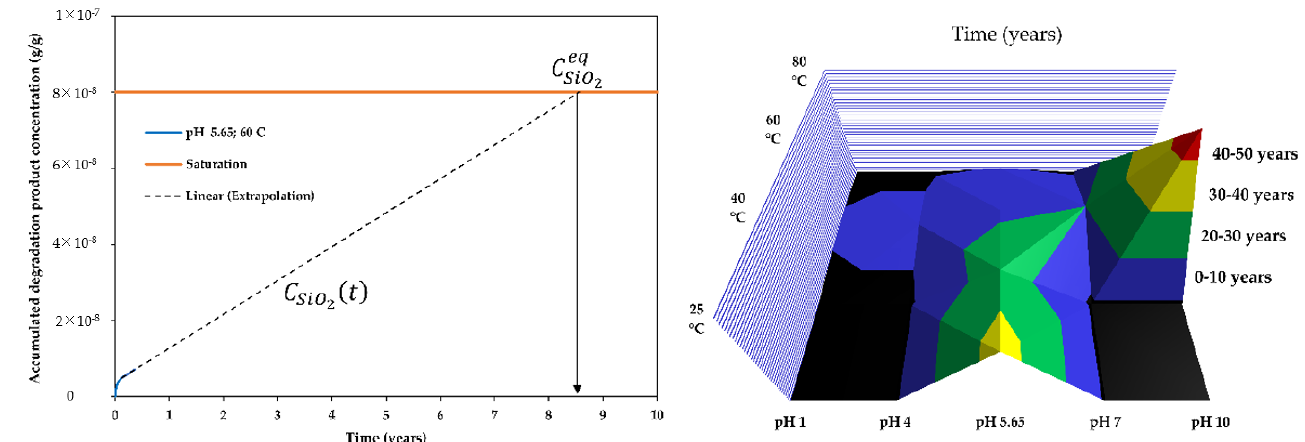
Figure 14. The extrapolation of the time-dependent degradation product concentrations in the interphase was used to estimate the time to saturation ( left ), and a summary of estimated times to reach the saturation of accumulated silica degradation products inside the composite for various environmental conditions is shown ( right ). Black areas represent the absence of data. Clarification: e.g., “8E3” stands for “8 × 10³”.